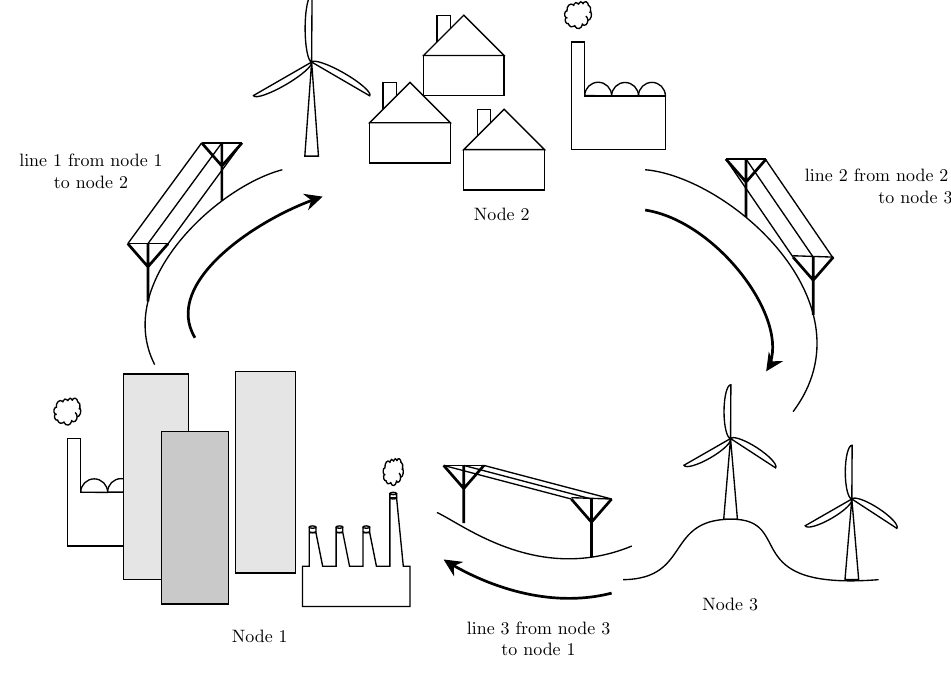
Figure 2. Schematic depiction of our test power